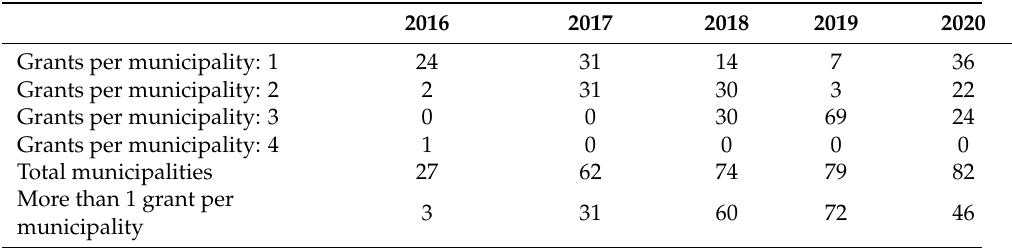
Municipalities with an FS, according to the number of sołectwa participating in the